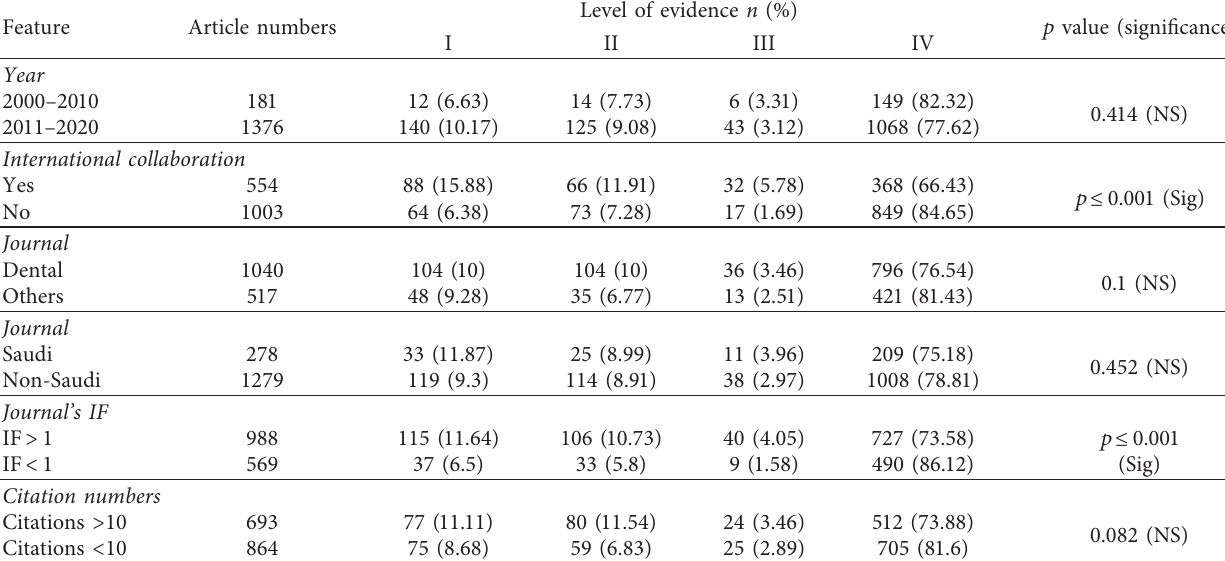
Table 4: Level of evidence of dental research in Saudi